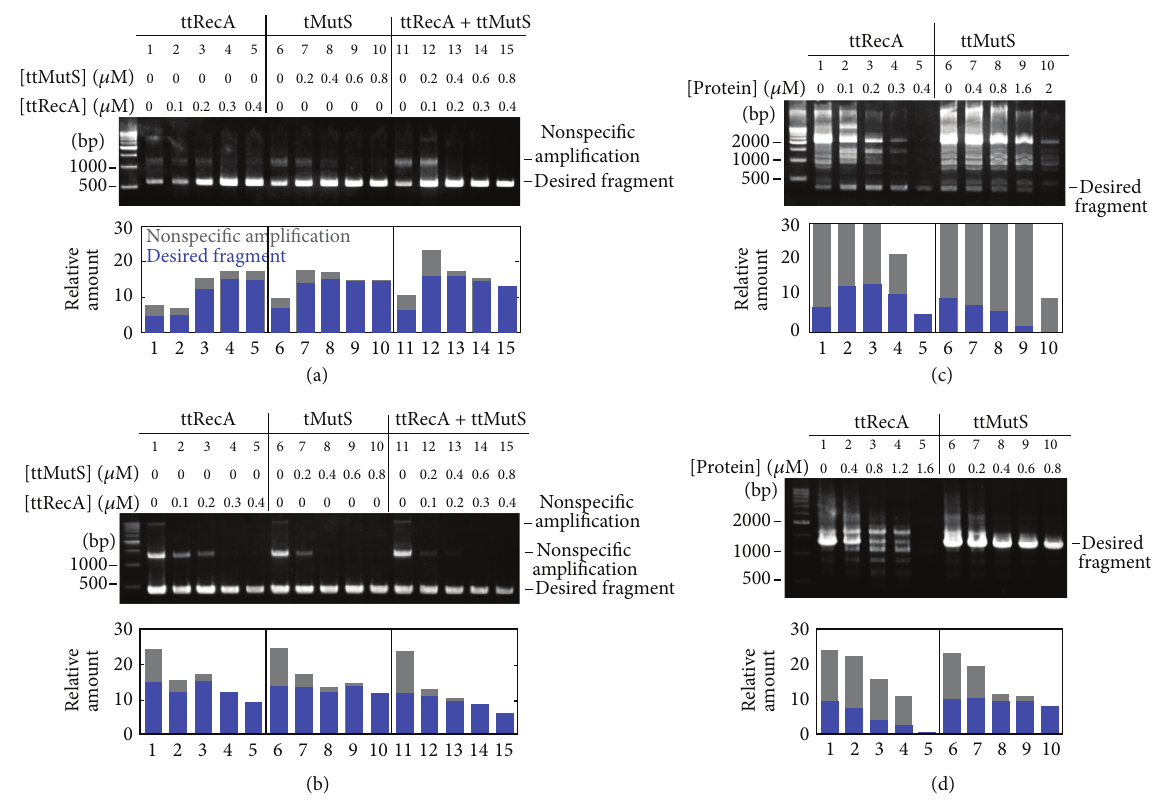
Figure 2: Various target sequences were amplified in the presence of ttRecA and ttMutS. (a) A 611bp region of the ttha0122 gene was amplified from T. thermophilus HB8 genomic DNA template in the presence of ttRecA and ttMutS. The amounts of amplified fragments were quantified and are shown as bar graphs in the lower panel. Gray and blue bars indicate nonspecific and desired amplifications, respectively. (b) A 423bp region of the ttha1806 gene was amplified from T. thermophilus HB8 genomic DNA template in the presence of ttRecA and ttMutS. (c) A 466bp region of the ttha1300 gene was amplified from T. thermophilus HB8 genomic DNA in the presence of ttRecA or ttMutS. Note that relatively high concentrations of ttMutS were used here. (d) A 1,278 bp region of the ttha1548 gene was amplified in the presence of ttRecA or ttMutS. Note that relatively high concentrations of ttRecA were used